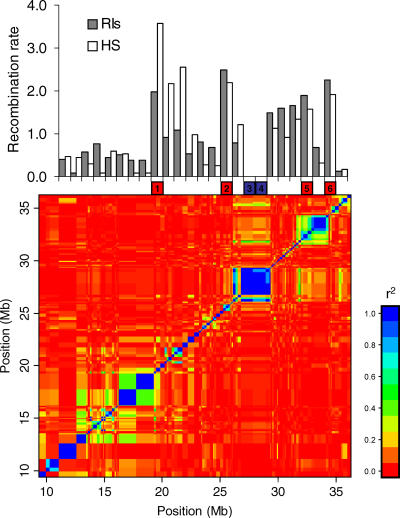
Relation between LD Levels in Inbred Strains and Recombination Rates in HS and RIs on Chromosome 7The top figure is the recombination rate (cM/Mb) for the HS and RIs in 1-Mb non-overlapping windows across a 25-Mb region in Chromosome 7. Below, the six boxes represent the location of four recombination jungles (in red) and two deserts (in blue) of 1 Mb each. The bottom figure is the LD structure of the same region based on the SNP genotypes of 55 inbred strains. Each dot represents the pairwise LD level between two different SNPs. Regions of high LD measured by r2 are in blue, whereas regions of linkage equilibrium are in red. As can be seen in this example, deserts tend to overlap with large blocks of LD, and jungles are typically located on the border of the blocks. The overlap proportion of the four recombination jungles with haplotype blocks is 0.00, 0.58, 0.55, and 0.35 for regions 1, 2, 5, and 6. The two deserts (3 and 4) overlap completely with haplotype blocks.